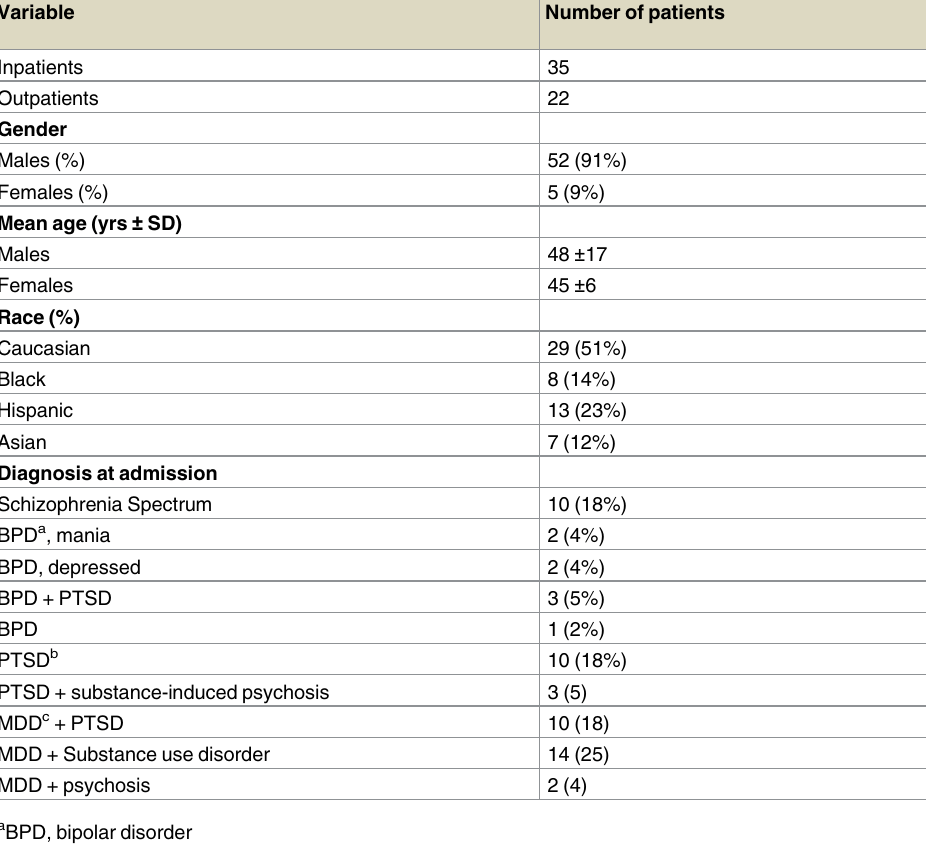
Table 1. Demographics of suicidal patients (N =